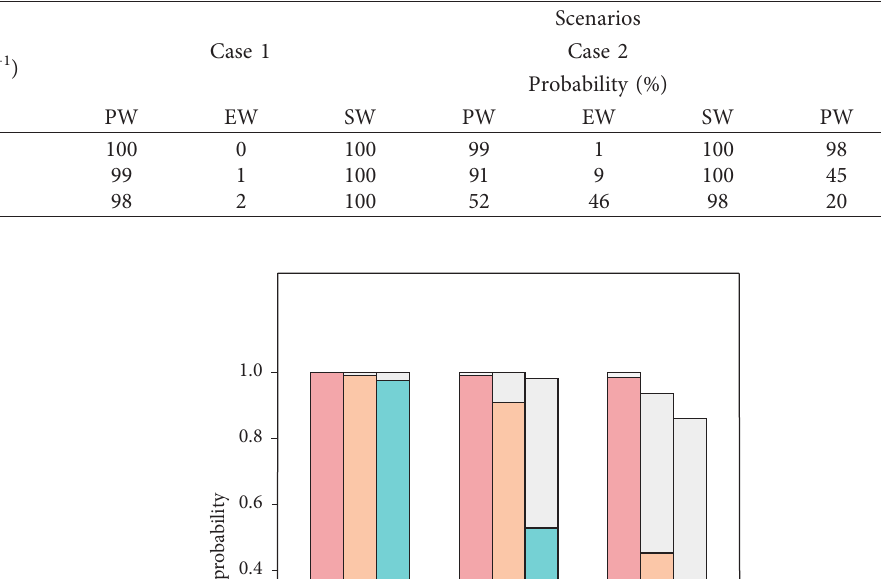
Table 3: Test results for scenario 1.